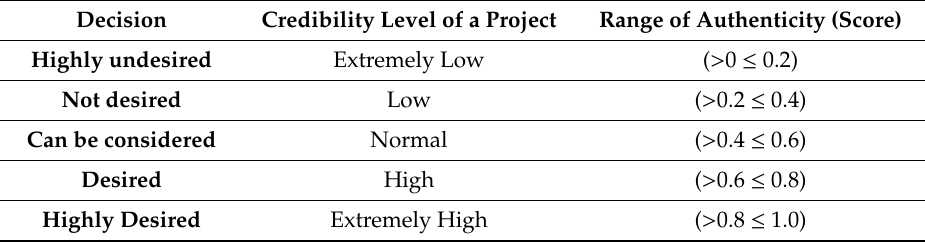
Table 7. Selection Criteria for Credibility.